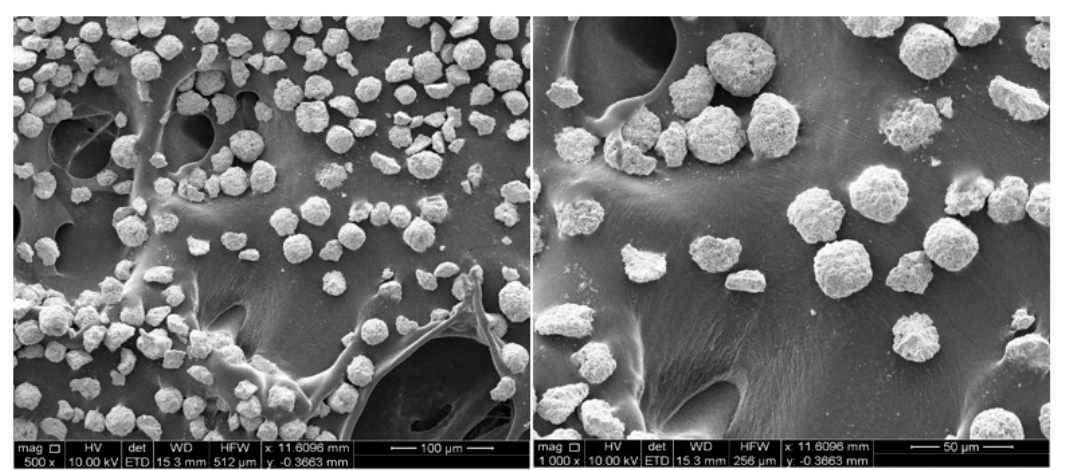
Figure 4. Scanning electron micrograph of the BiFeO 3 powder.